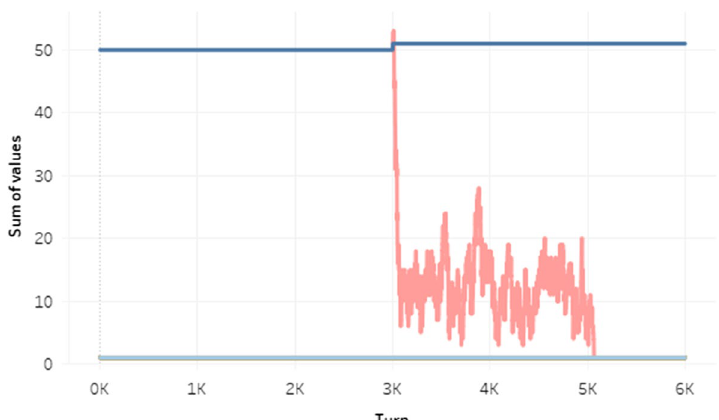
Fig. 7 Introduction of the cryptocurrency payments, case 1-A-2: Time series change of the sum of possession. Blue line is the fiat money good, red line is the cryptocurrency good, and other colors represent remaining goods. This case represents the total amount of goods for the same simulation as that of Fig. 5. After the introduction of cryptocurrency good, the total amount decreases drastically, remains below 25, and then disappears. Compared with Fig. 5, the time of disappearance coincides with the time when the view is